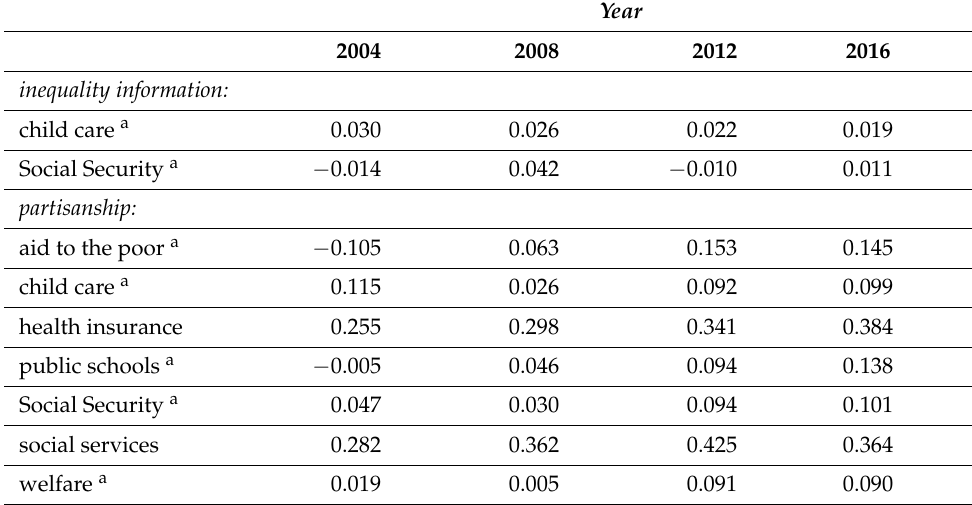
Table 4. Year-specific average marginal effects when interaction with time is